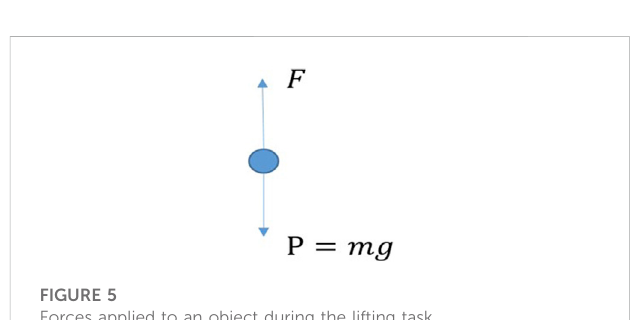
FIGURE 5 Forces applied to an object during the lifting